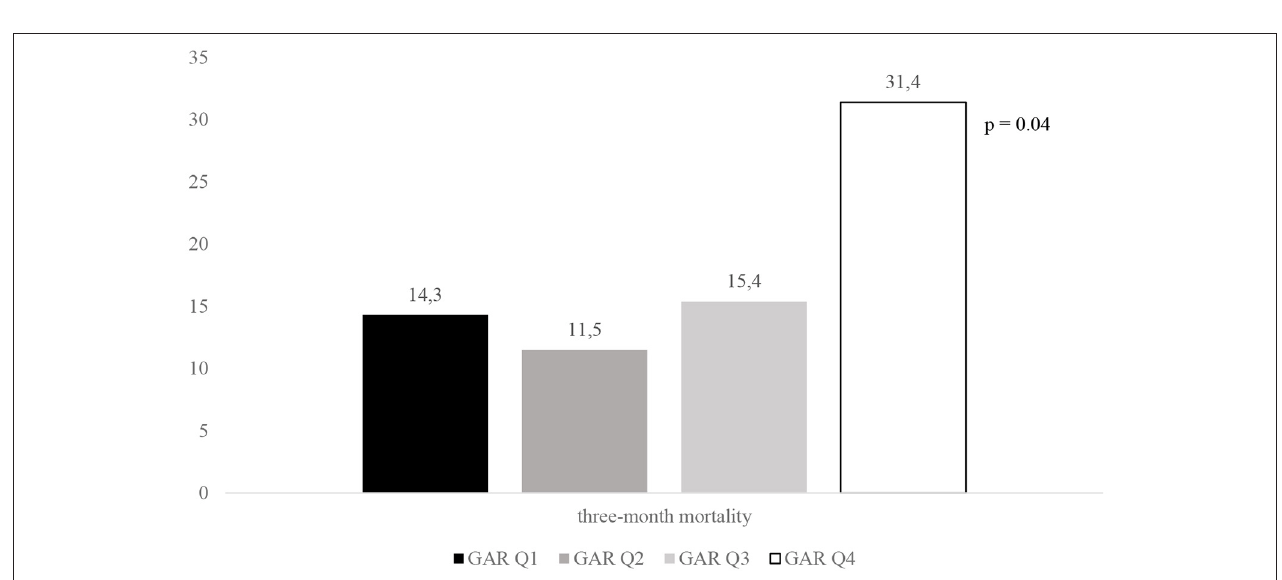
FIGURE 3 | Rates of 3-month mortality according to GAR quartile. GAR Q1, first glucose-to-glycated hemoglobin ratio quartile; GAR Q2, second glucose-to-glycated hemoglobin ratio quartile; GAR Q3, third glucose-to-glycated hemoglobin ratio quartile; GAR Q4, fourth glucose-to-glycated hemoglobin ratio quartile.